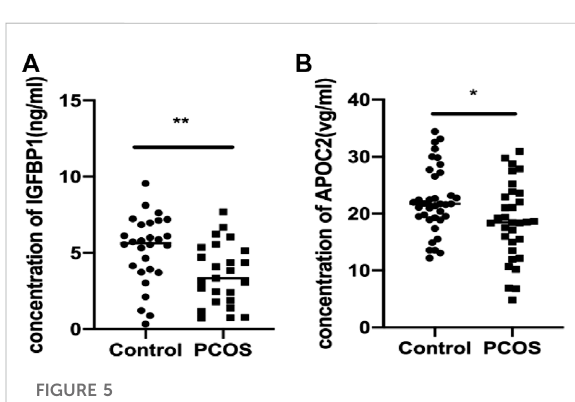
FIGURE 5 Validation of IGFBP1 and APOC2 concentrations in follicular fl uid of PCOS patients and the controls using ELISA. Graphical resultsareshowninmean±SD,* p < 0.05,** p < 0.01,*** p < 0.001. (A) Insulin-like Growth Factor Binding protein 1(IGFBP1_. (B) Apolipoprotein C2